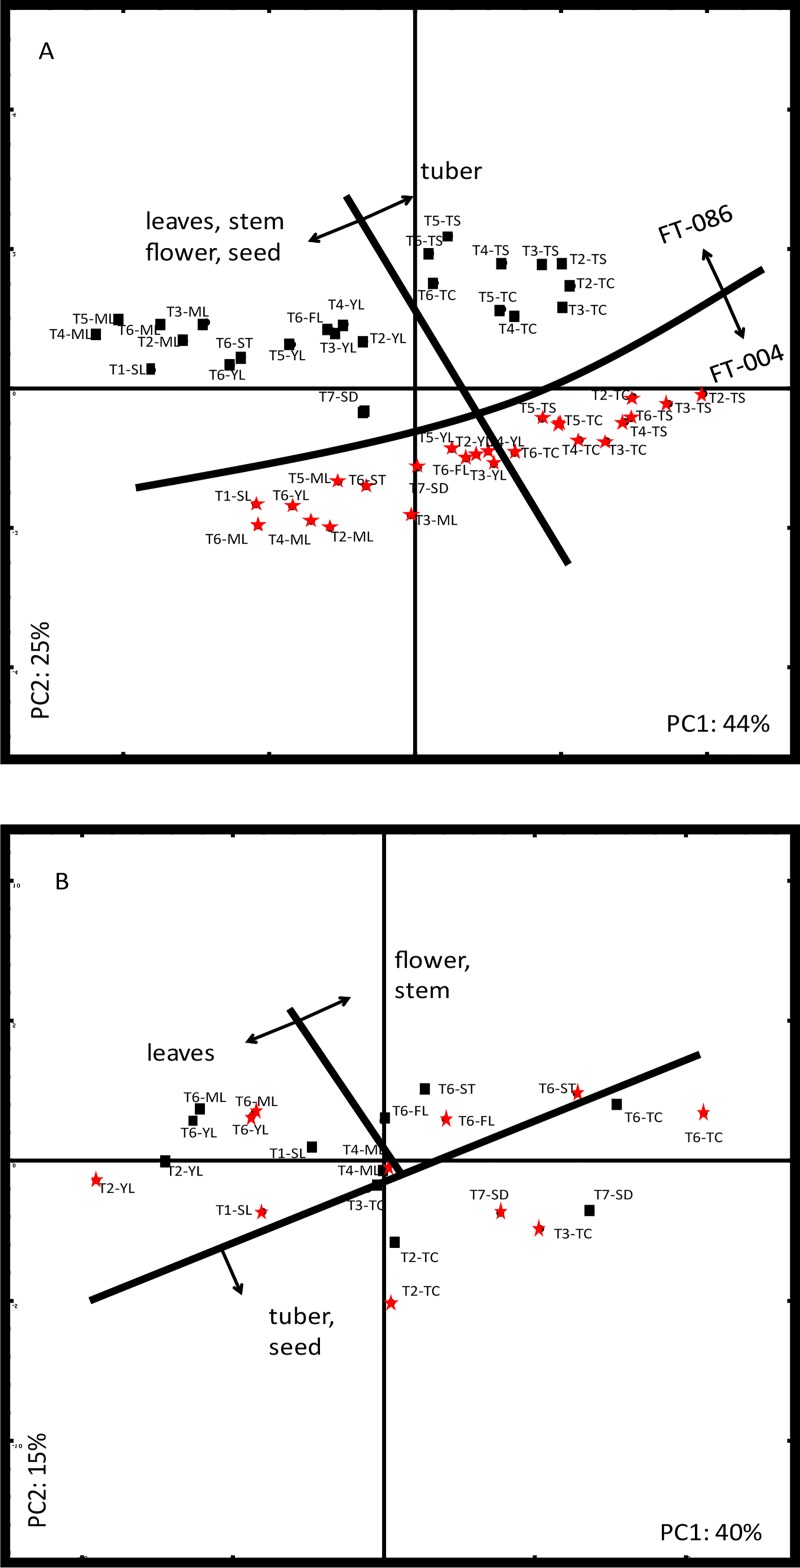
Principle component analysis of GLS data (A) and gene expression data (B) of investigated turnip tissues from two accessions at different timepoints. Average values of three biological replicates were used for each datapoint. Accessions: black squares: FT-086; red stars: FT-004. Tissues: FL: flower; ML: mature leaves; SD: seed; SL: seedling; ST: stem; TC: tuber core; TS: tuber surface; YL: young leaves. Timepoints: T1: 20 days after germinating; T2: 40 days; T3: 54 days; T4: 71 days; T5: 84 days; T6: 272 days; T7: 349 days.